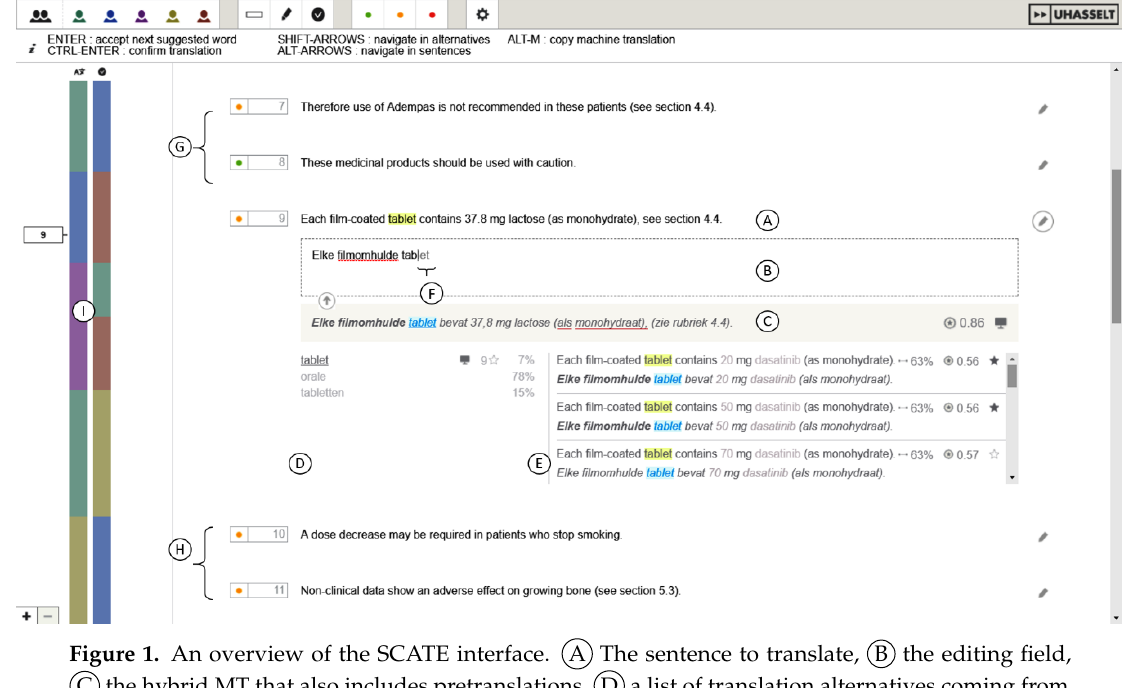
Figure 1. An overview of the SCATE interface. A The sentence to translate, B the editing field, C the hybrid MT that also includes pretranslations, D a list of translation alternatives coming from the term base, TM and MT, E fuzzy matches, F suggestion from autocomplete, G previous source sentences, H upcoming source sentences and I a progress